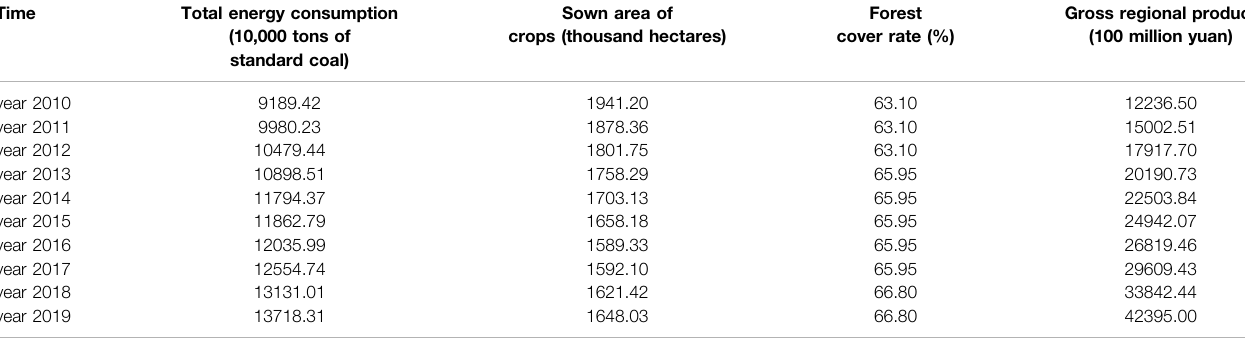
TABLE 1 | Energy, crops, forests and other natural resource projects and regional GDP data in Fujian Province.